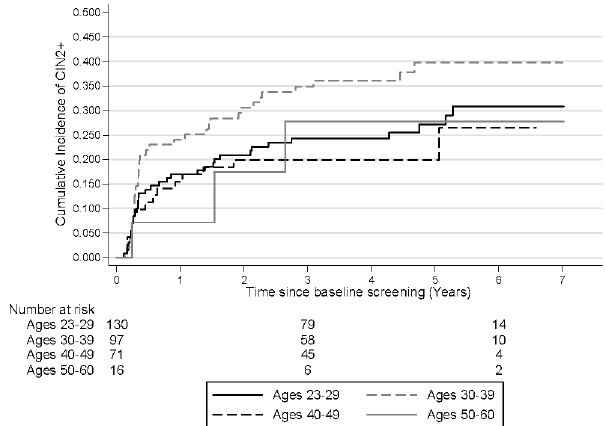
Fig 2. Cumulative incidence of CIN2+ by baseline age. Log rank p-value: 0.1499 CIN2+: cervical intraepithelial neoplasia grade 2 or worse